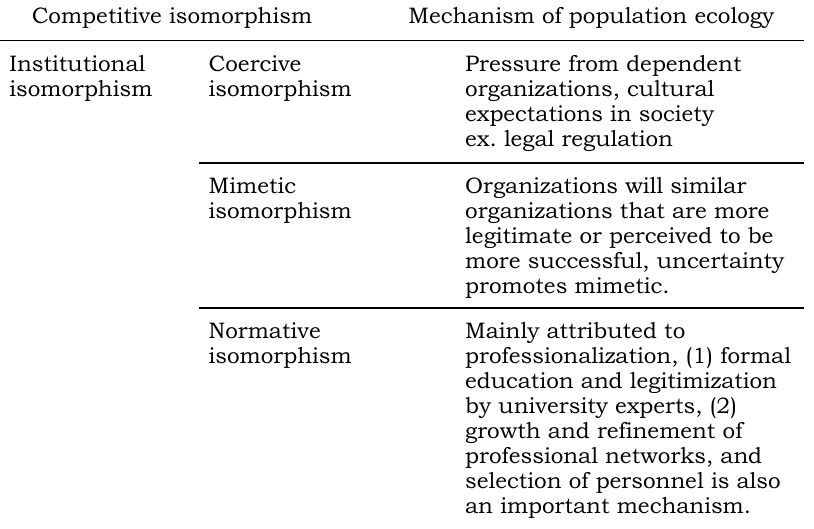
Table 2. Mechanism of isomorphic organizational change Mechanism = source of isomorphic organizational change Competitive